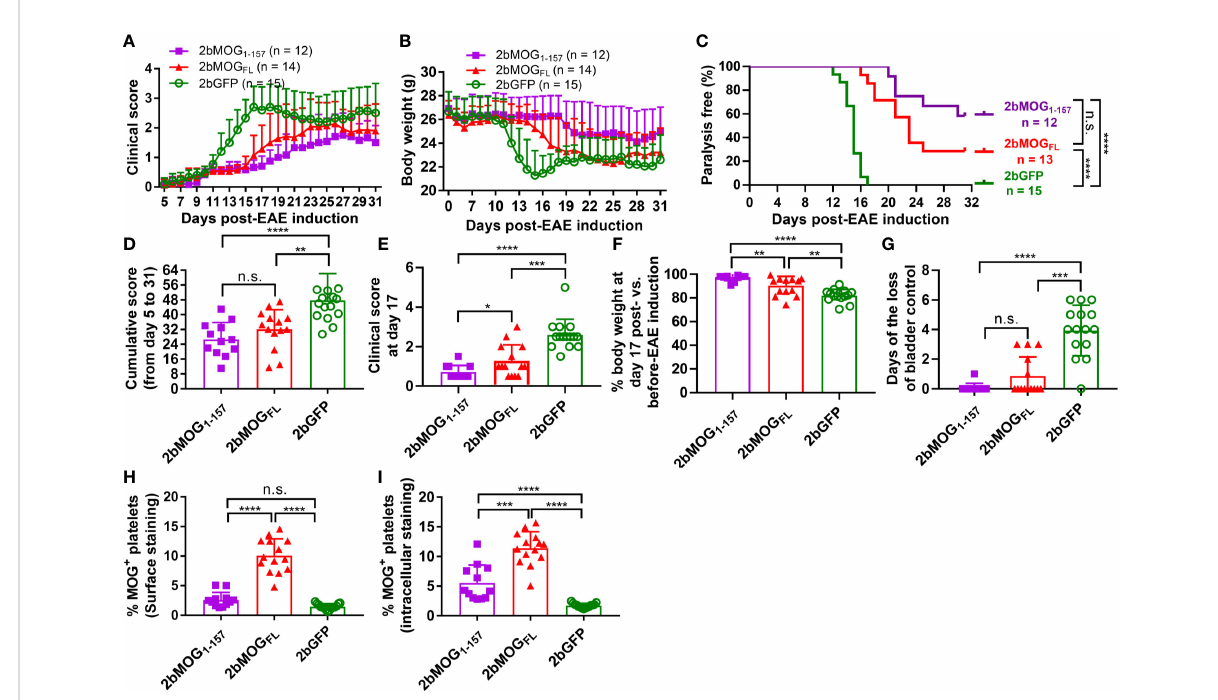
FIGURE 5 Eliminating MOG transmembrane domains (MOG 1-157 ) enhanced clinical ef fi cacy in immune tolerance induction in EAE. After lentivirus transduction of HSCs followed by HSCT and at least 3 months of BM reconstitution, EAE was induced. Clinical scores and body weights were monitored daily during the study period of 5-31 days after EAE induction. Loss of bladder control (urinary incontinence) during days 5-20 was assessed by visual observation of wetness on the animal ’ s fur on the caudal abdomen. (A) The average daily EAE score of 2bMOG 1-157 -, 2bMOG FL -, 2bGFP-transduced recipients over time are shown. (B) Body weights of 2bMOG 1-157 -, 2bMOG FL -, 2bGFP-transduced recipients over time are shown. (C) The percentages of transduced recipients that were paralysis free after EAE induction are shown. (D) The cumulative scores of 2bMOG 1-157 , 2bMOG FL , and 2bGFP recipients up to 31 days after EAE induction are shown. (E) The EAE score of 2bMOG 1-157 -, 2bMOG FL -, and 2bGFP-transduced recipients at day 17 after EAE induction are shown. (F) Body weights of the 2bMOG 1-157 , 2bMOG FL , and 2bGFP recipients at day 17 after EAE induction are shown. (G) Days of bladder control loss in transduced recipients after EAE induction during the study period are shown. (H) Surface expression of MOG in transduced recipients is shown. (I) Intracellular expression of MOG in transduced recipients is